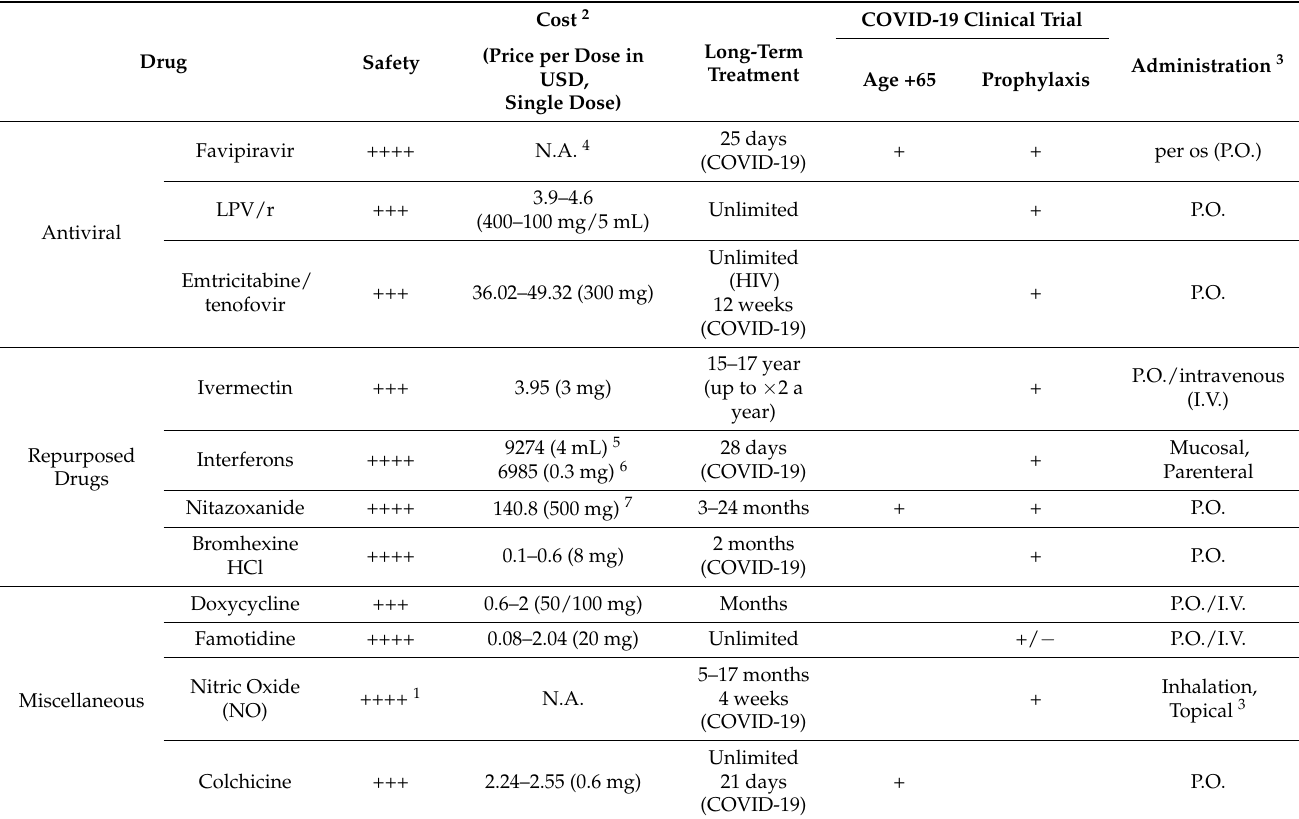
Table 2. Candidate SARS-CoV-2 prophylactic drugs currently in clinical